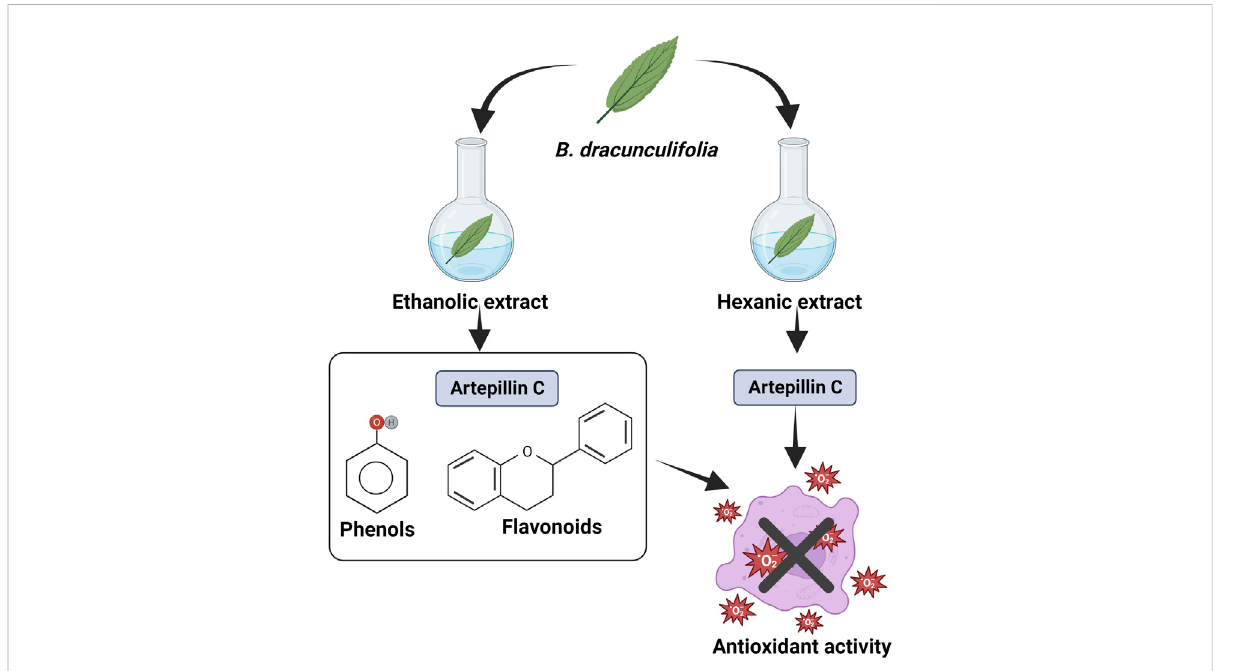
FIGURE 12 Antioxidant activity of ethanolic and hexane extracts from B. dracunculifolia leaves (Veiga et al.,